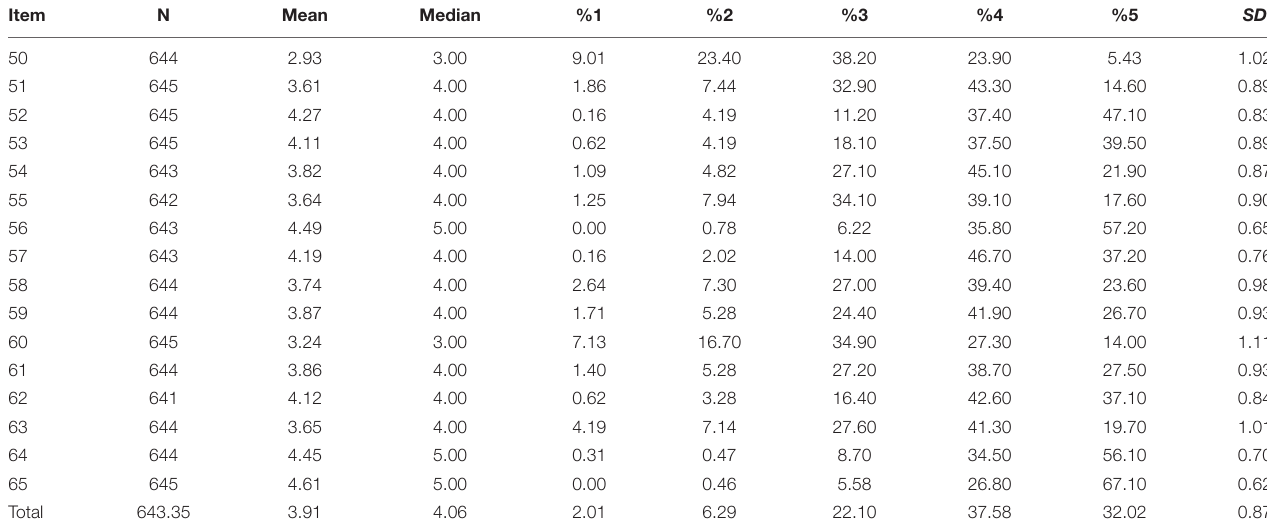
TABLE 4 | Descriptive statistics regarding opinions on the use of